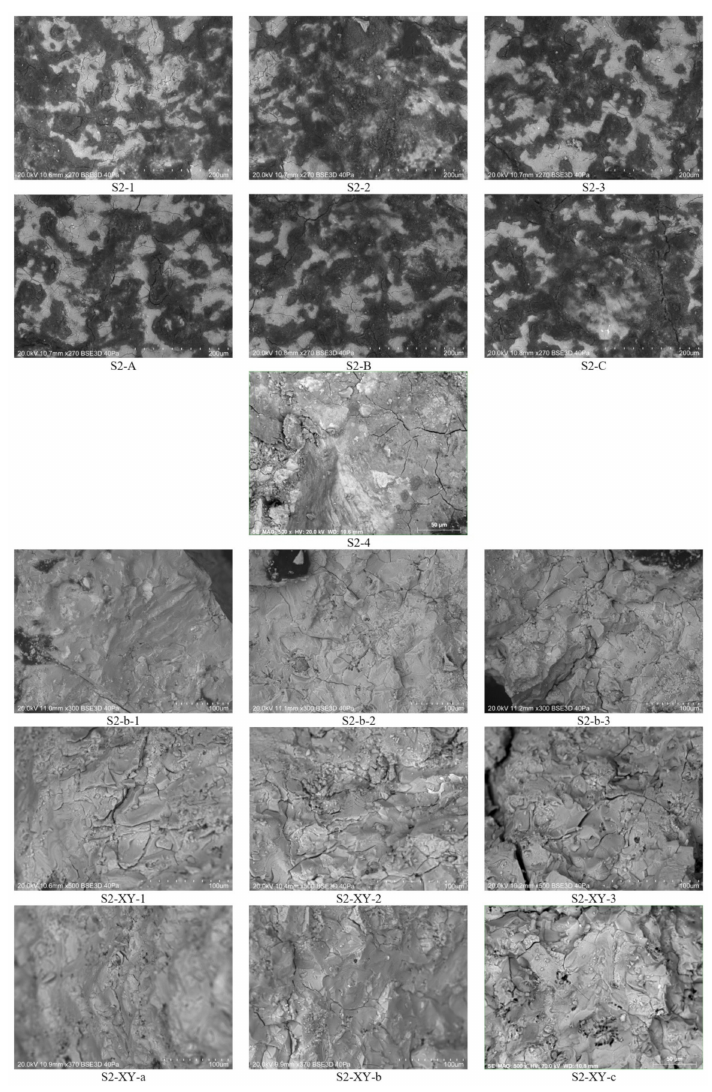
Figure 7. SEM images of the selected analysis